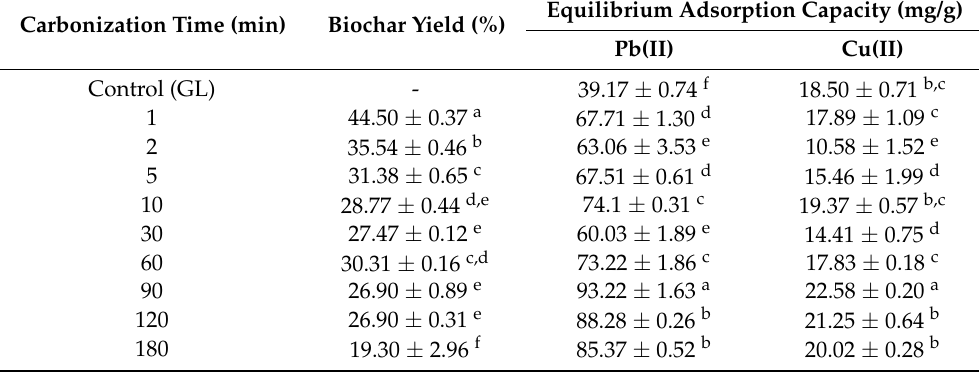
Table 4. Biochar yield and heavy metal adsorption capacities according to carbonization time. Data are the means ± standard deviation. Means with the same letter in a column do not significantly differ at p < 0.05, as determined by Duncan’s multiple range test with SPSS version 24 (IBM, Armonk, NY, USA). The high mean to low mean sequence is marked by the letters a to f